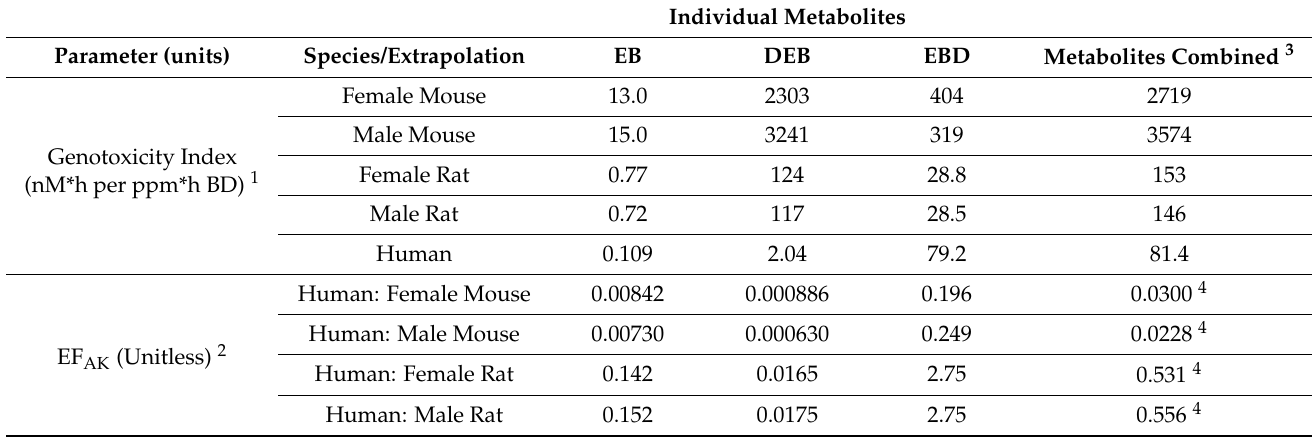
Table 6. Data-derived extrapolation factors to quantify species differences in BD toxicokinetics (EF AK ). Individual